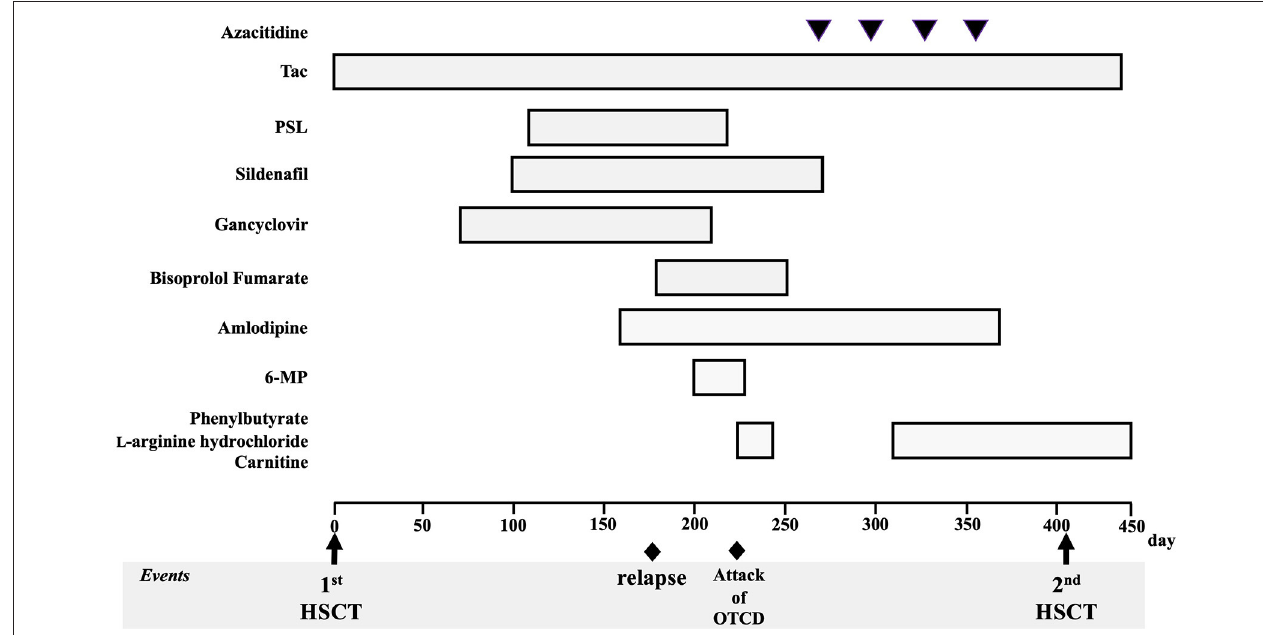
FIGURE 2 | Patient’s clinical course and treatment for juvenile myelomonocytic leukemia and complications. Tac, tacrolimus; PSL, prednisolone; 6-MP, 6-mercaptopurine; HSCT, hematopoietic stem cell transplantation; OTCD, ornithine transcarbamylase